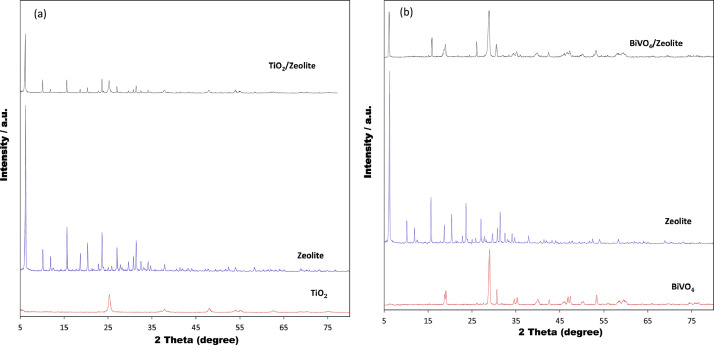
The XRD pattern of the studied materials: a) TiO2/Zeolite, TiO2, Zeolite;b) BiVO4/Zeolite, BiVO4, Zeolite.